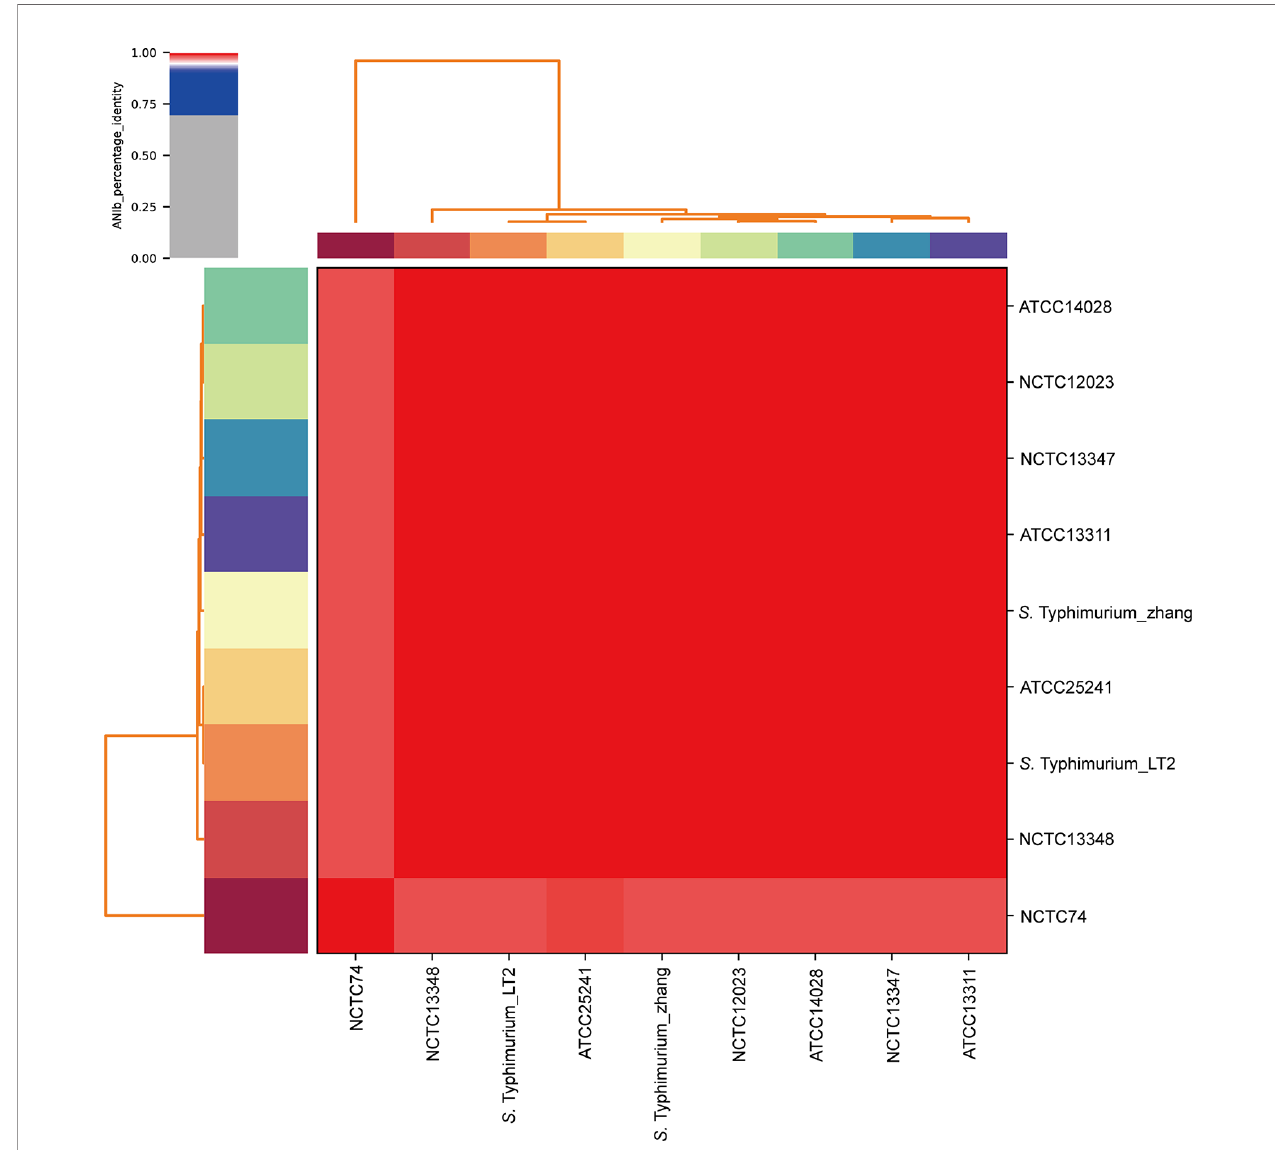
FIGURE 3 | ANIb analysis of S. Typhimurium_zhang and eight S. Typhimurium type strains Eight S. Typhimurium type strains (ATCC14028, NCTC12023, NCTC13347, ATCC13311, ATCC25241, Typhimurium_LT2, NCTC13348, NCTC74) were downloaded and compared with the genomic sequence of S. Typhimurium_zhang. ANIb analysis was completed using pyani with default settings and visualized by heatmaps. ANIb, average nucleotide identity